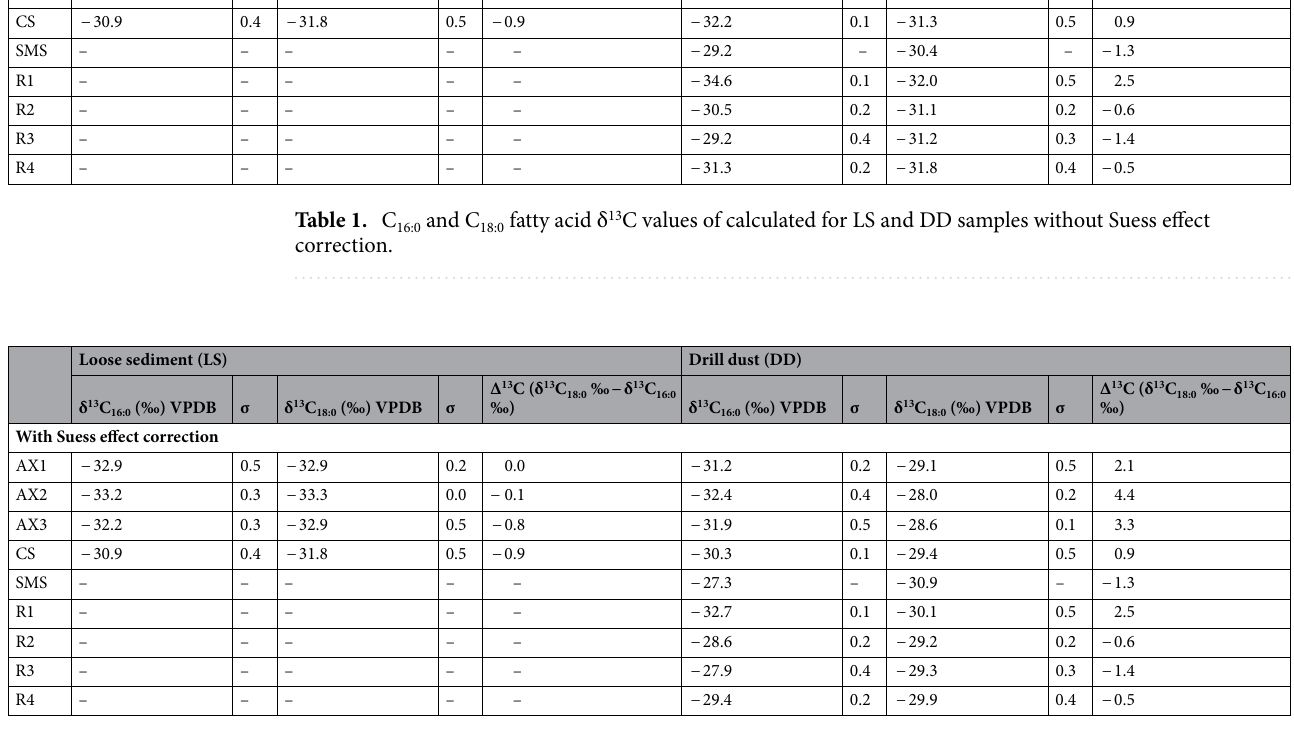
Table 2. C 16:0 and C 18:0 fatty acid δ 13 C values calculated for BS and DD samples with Suess effect correction .